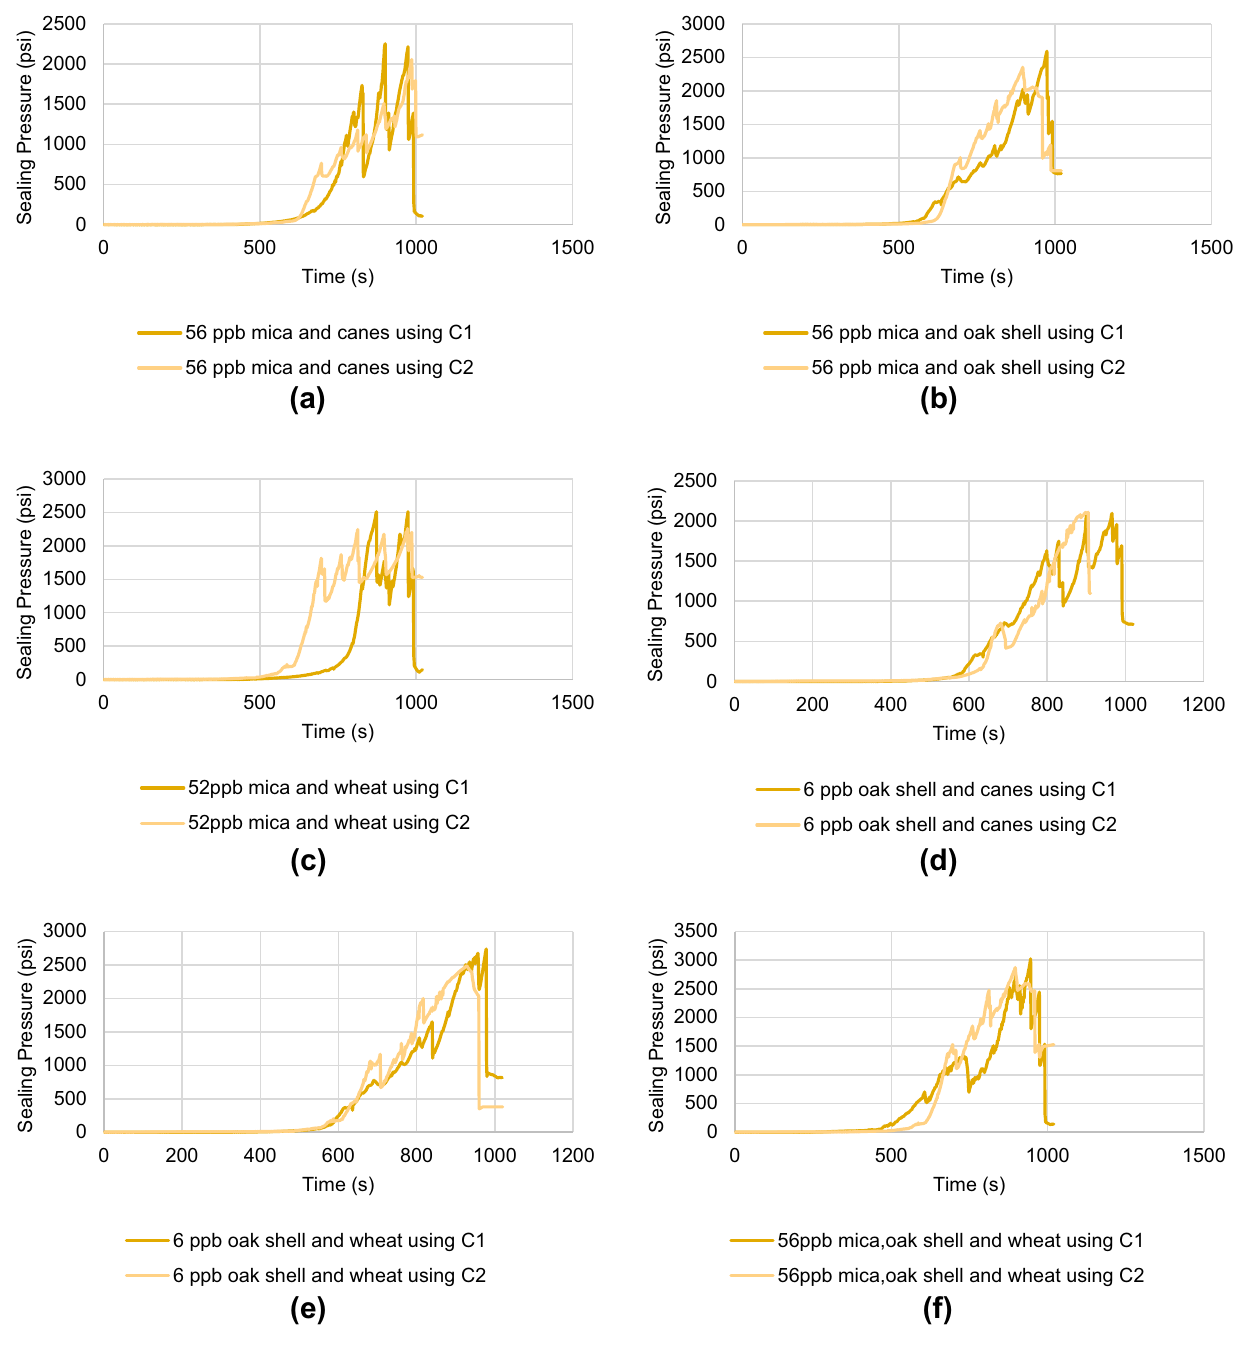
Fig. 29 HPA Pressure vs. Time plot for the mixture of LCMs showing maximum sealing pressure at the best particle size and concentration and different fracture